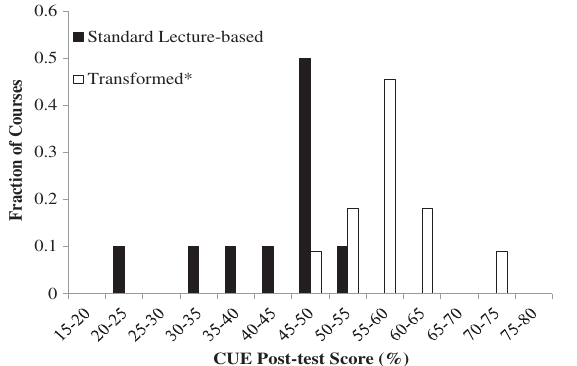
FIG. 4. Histogram of average course score on the CUE across 7 institutions demonstrating improved performance for courses using CU ’ s transformed materials (11 courses, 9 CU; 329 students, 312 CU) relative to courses using only traditional lecture (10 courses, 5 CU; 303 students, 191 CU). All trans- formed courses used some or all of CU ’ s transformed electro- statics materials.